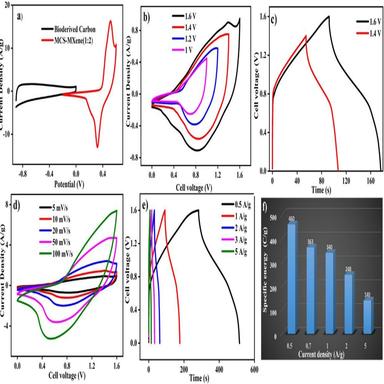
(a) CV profile of MCS-MXene (1:2) and bio-derived carbon at 5 mV/s from the half-cell measurement; (b) CV and (c) CD profile of fabricated hybrid asymmetric device with different cell potential; (d) CV and (e) CD profile of fabricated hybrid asymmetric device at different scan rates and current densities, respectively. (f) Specific capacity vs. current density plot for the hybrid asymmetric device.